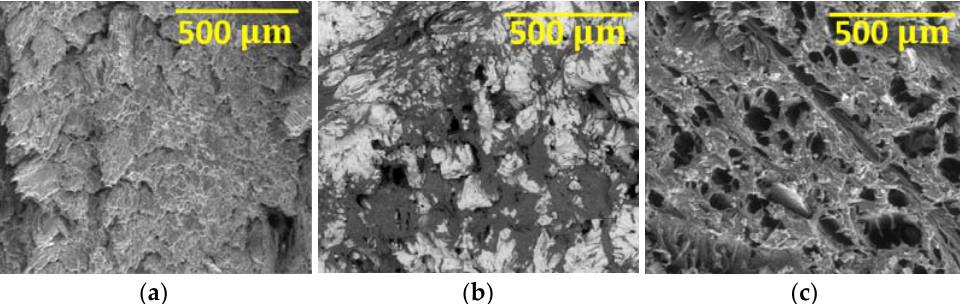
Figure 9. SEM image of the beech sample at a magnification of 200 × : ( a ) before immersion, ( b ) after three weeks, ( c ) after three months.